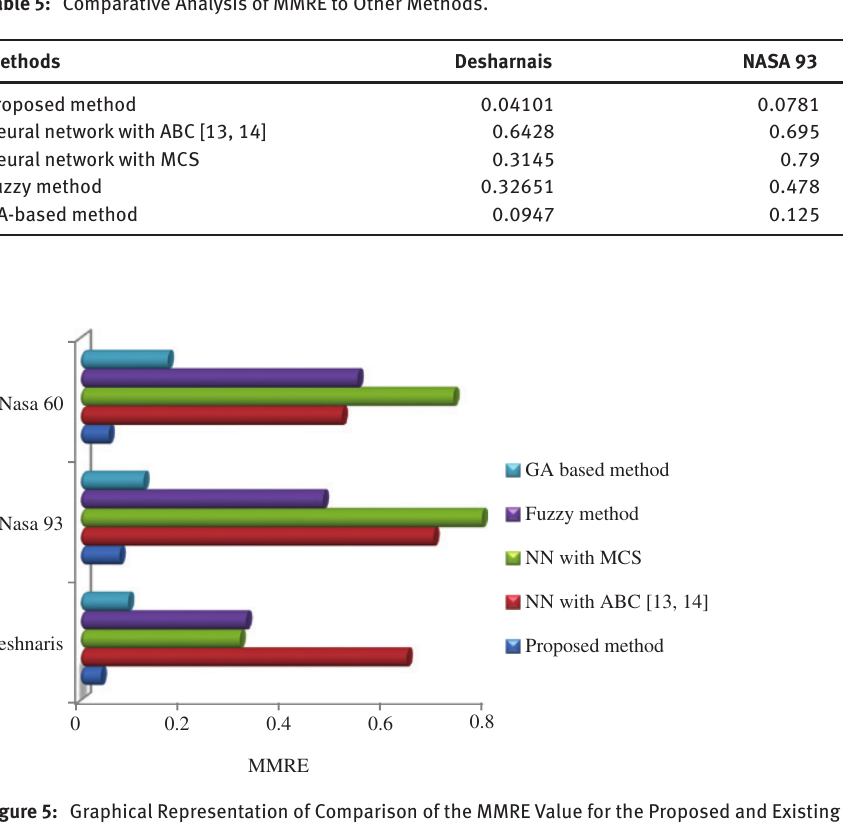
Figure 5: Graphical Representation of Comparison of the MMRE Value for the Proposed and Existing